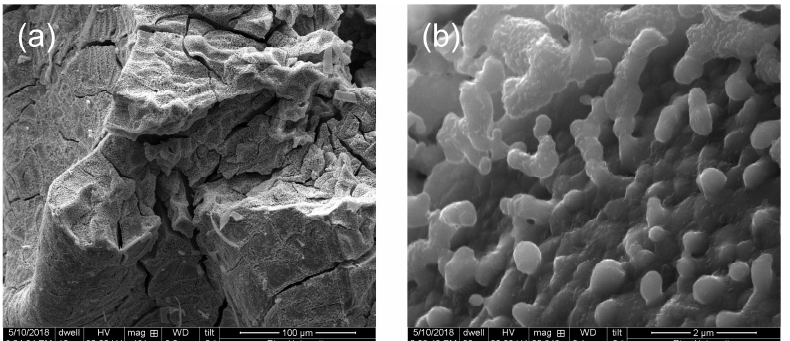
Figure 8. SEM images of the product from thermolysis of 1 at 1100 °C under an atmosphere of 5% H 2 (Ar balance). Scale bar: ( a ) 100 μm and ( b ) 2 μm.